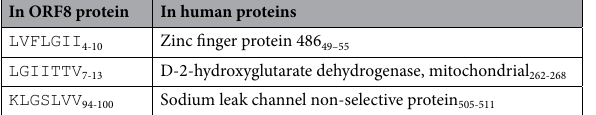
In ORF8 protein